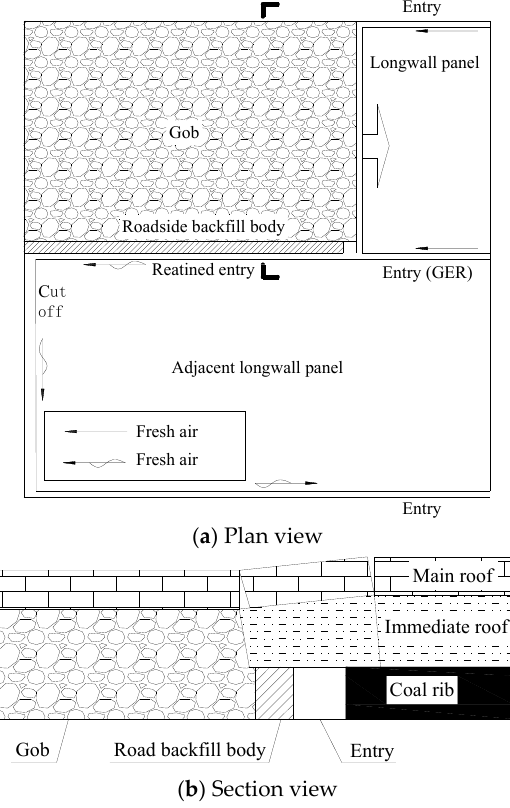
Figure 1. View of the GER schematic diagram.